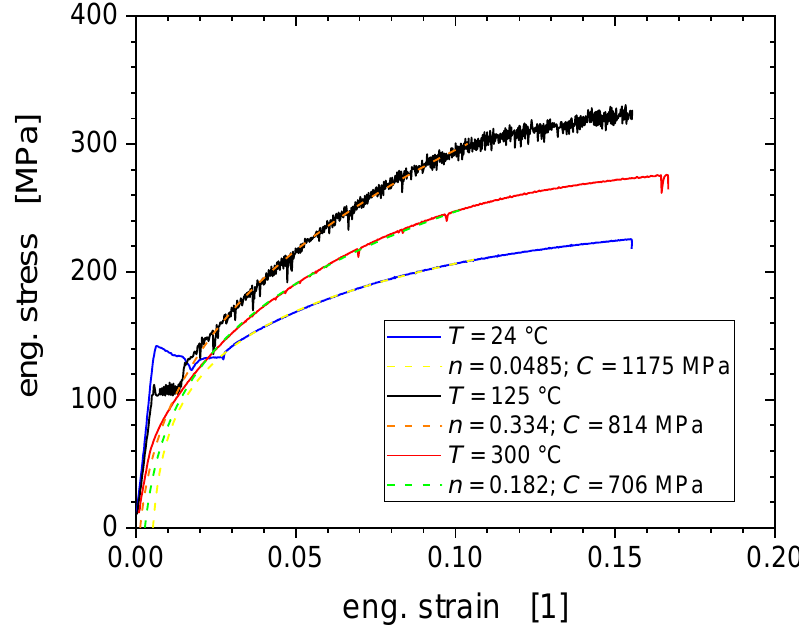
Figure 11. Stress-strain curves from tensile tests exhibiting serrated yielding at 125 °C and Lüders band propagation at RT and 125 °C. The dashed curves represent power law hardening rules σ = C ( ε − ε 0 ) n with hardening exponents n, strength coefficients C , and offset strains ε 0 as reported in the legend.